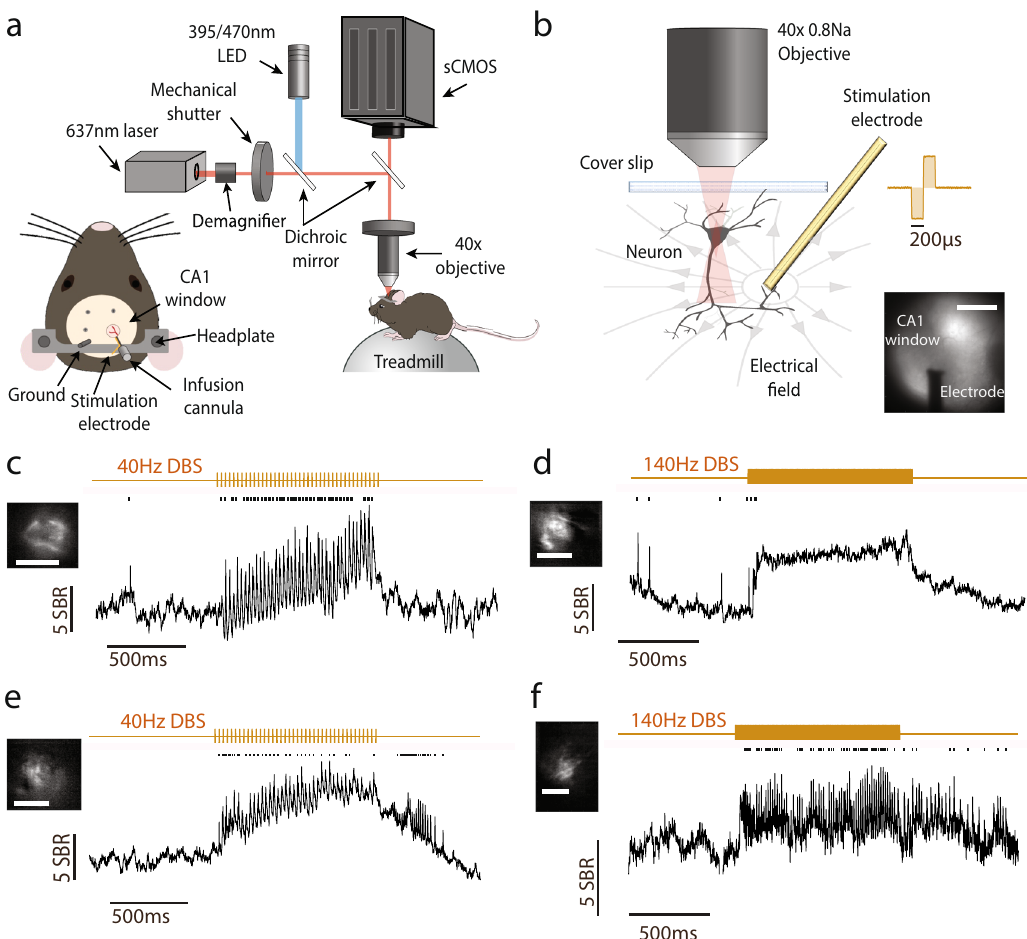
Fig. 1 | Single-cell SomArchon fl uorescence voltage imaging enables artifact- free neural recordings during DBS. a Illustration of the experimental setup, the optical imaging window, and the animal preparation. The schematic was adapted fromPiatkevichetal.2019. b SchematicrepresentationofarecordedCA1neuronin the electric fi eld generated by the electrode a few hundred microns away, and an example empirically measured electrical stimulation waveform. Lower right is an example imaging fi eld showing GFP fl uorescence from neurons expressing SomArchon-GFP and CoChR and the shadow of the nearby electrode. Scale bar 500 µ m. The schematic neuron was adapted from Scidraw (doi.org/10.5281/